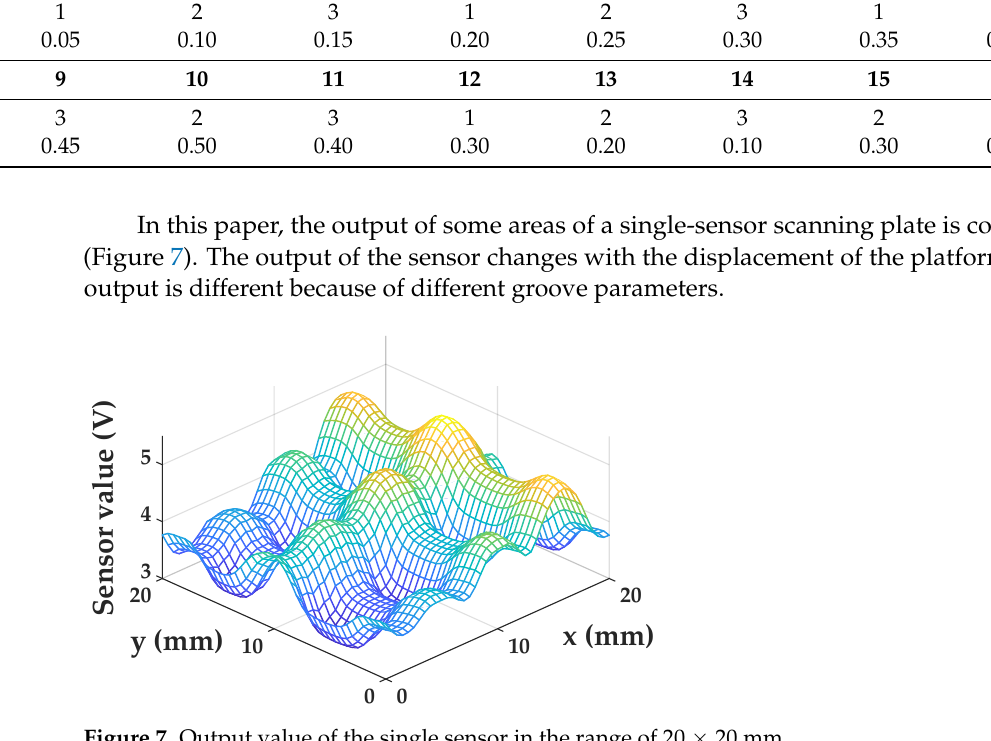
Table 3. Groove parameters in the Y-direction (Starting from Y = 0).